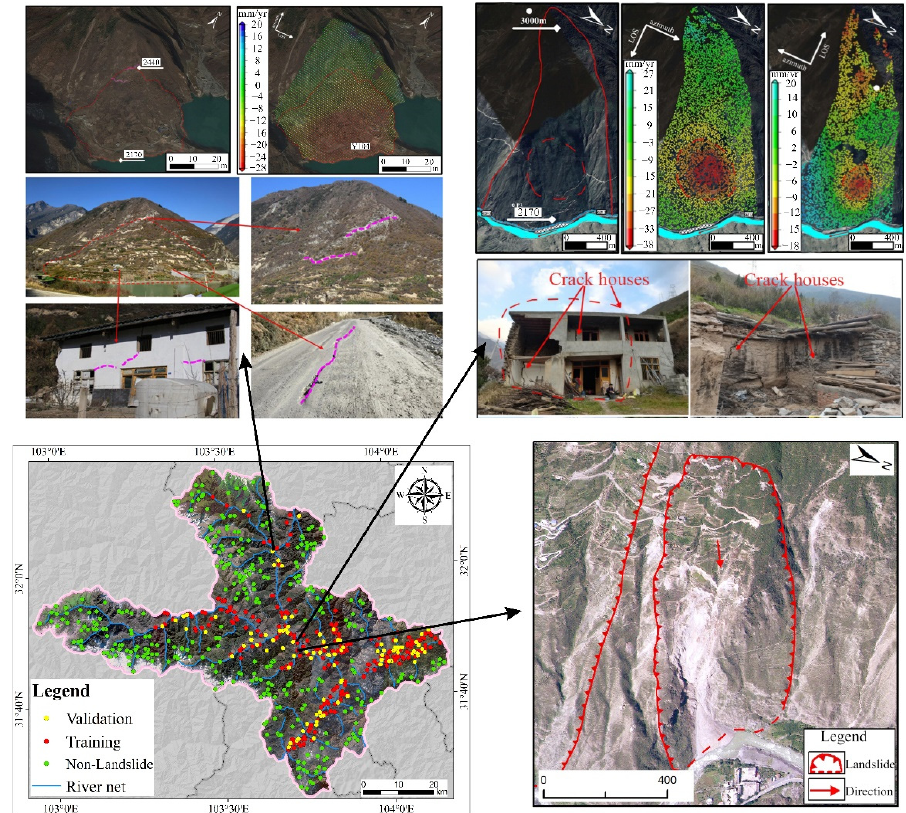
Figure 3. Landslide distribution and presentation of typical landslides in the study area (Gaofen-2 base map).